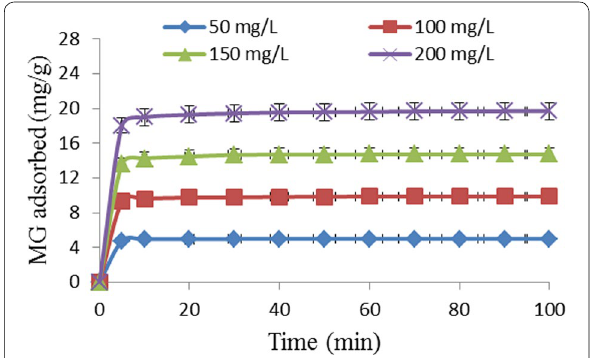
Fig. 1 Effect of contact time and initial concentration of dye on removal of MG by